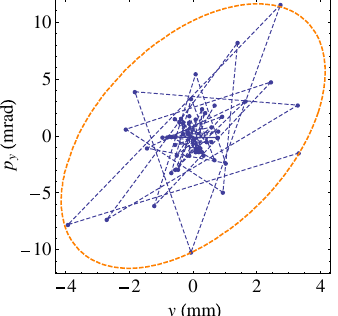
FIG. 10. Blue points represent the measured phase space coordinates, with the dashed blue line included to show the turn by turn progression. The orange dashed line is the phase space ellipse which is given by the fitted action and Courant-Snyder parameters.